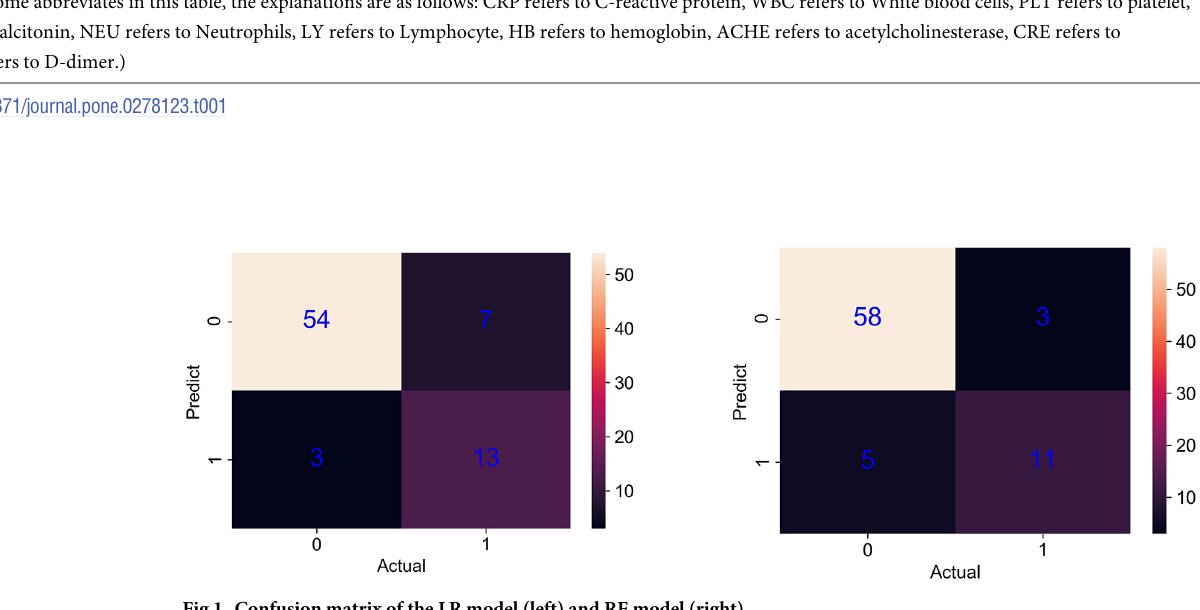
Fig 1. Confusion matrix of the LR model (left) and RF model (right).